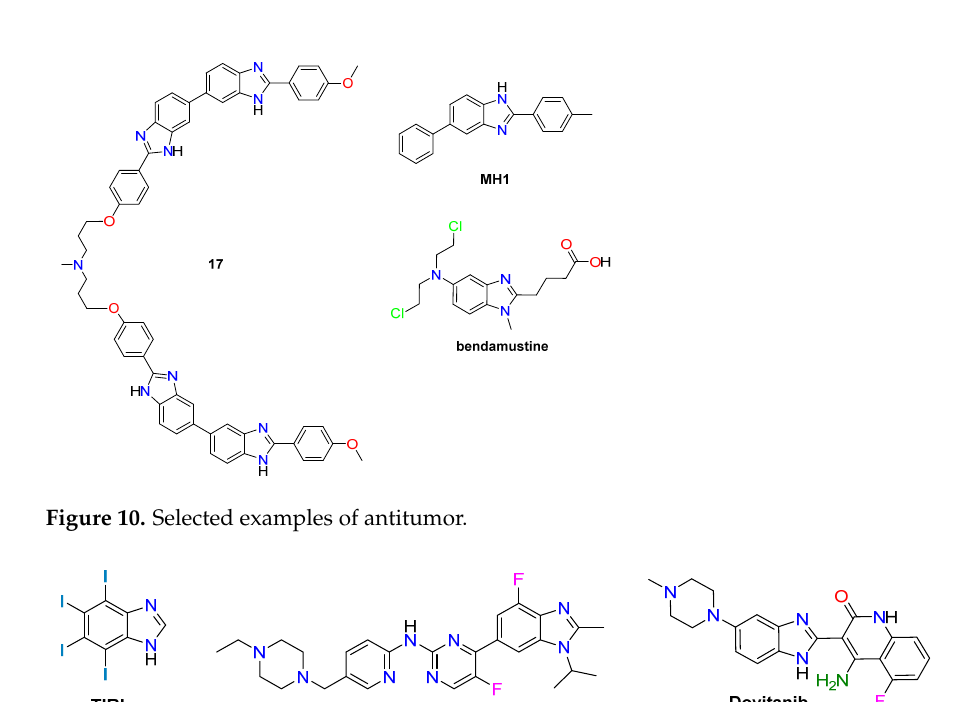
Figure 11. Selected examples of kinase inhibitors.